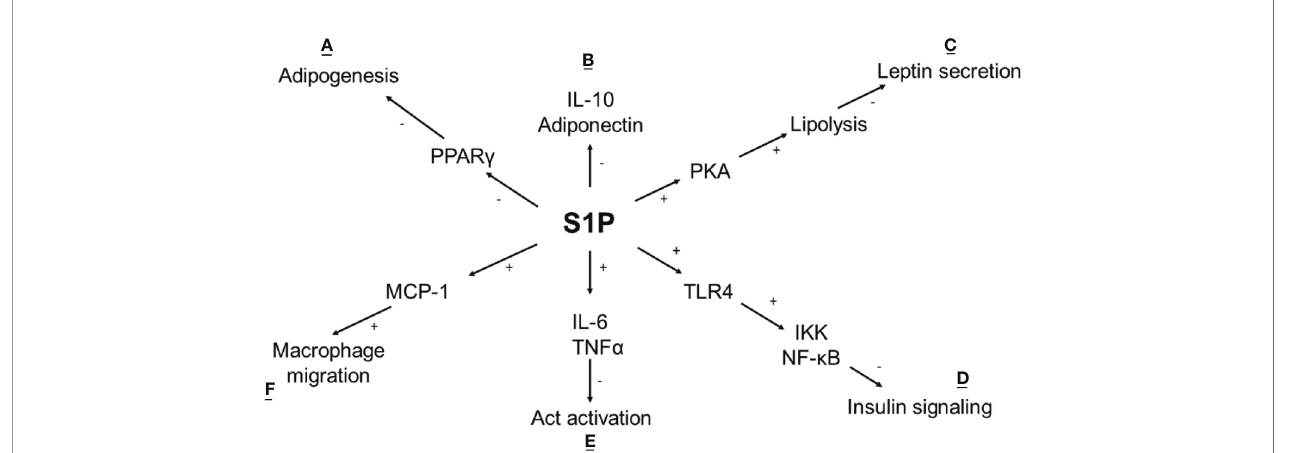
FIGURE 2 | Metabolic effect of S1P in adipocyte. (A) S1P inhibits adipogenesis by affecting the expression of transcriptional factor PPAR g (45); (B) S1P reduces the anti-in fl ammatory response (IL-10) and adiponectin synthesis which is accompanied by (E) an increased proin fl ammatory cytokine levels (IL-6, TNF a ) lead to the activation of PP2A leaving Akt dephosphorylated and inactive (46); (C) In cAMP/PKA dependent pathway S1P stimulates lipolysis and inhibits insulin-mediated leptin synthesis (47); (D) S1P intensi fi es TLR4 activation cause impaired insulin signalling via IKK- NF- k B axis (48); (F) S1P stimulates secretion of chemokine MCP-1 leads to increased macrophage migration (49); (+) activation, (-) inhibition, TNF a -tumor necrosis factor, IL-6, interleukin 6; IL-10, interleukin 10; Act, protein kinase 3; TLR4, Toll like receptor 4; IKK, inhibitor kappa kinase; NF- k B, nuclear factor k B; PKA, protein kinase A; PPAR g , peroxisome proliferator-activated receptor gamma; MCP-1, monocyte chemoattractant